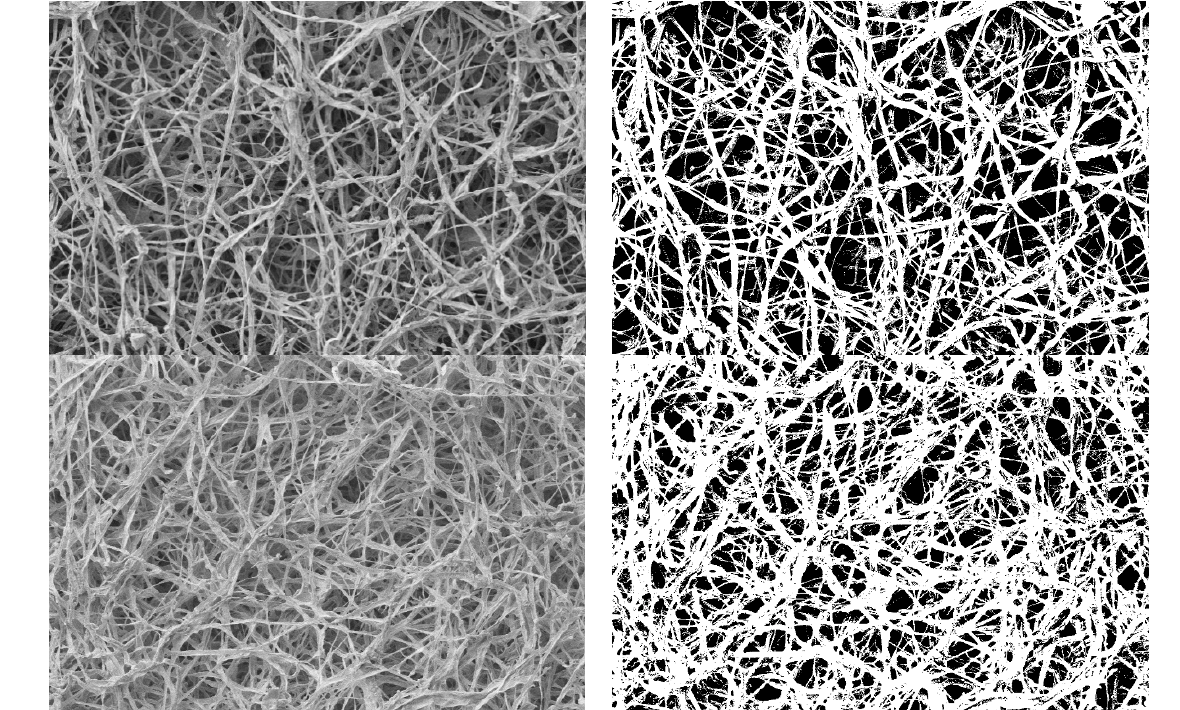
Figure 12. Examples of SEM images before ( left ) and after ( right ) binarization.